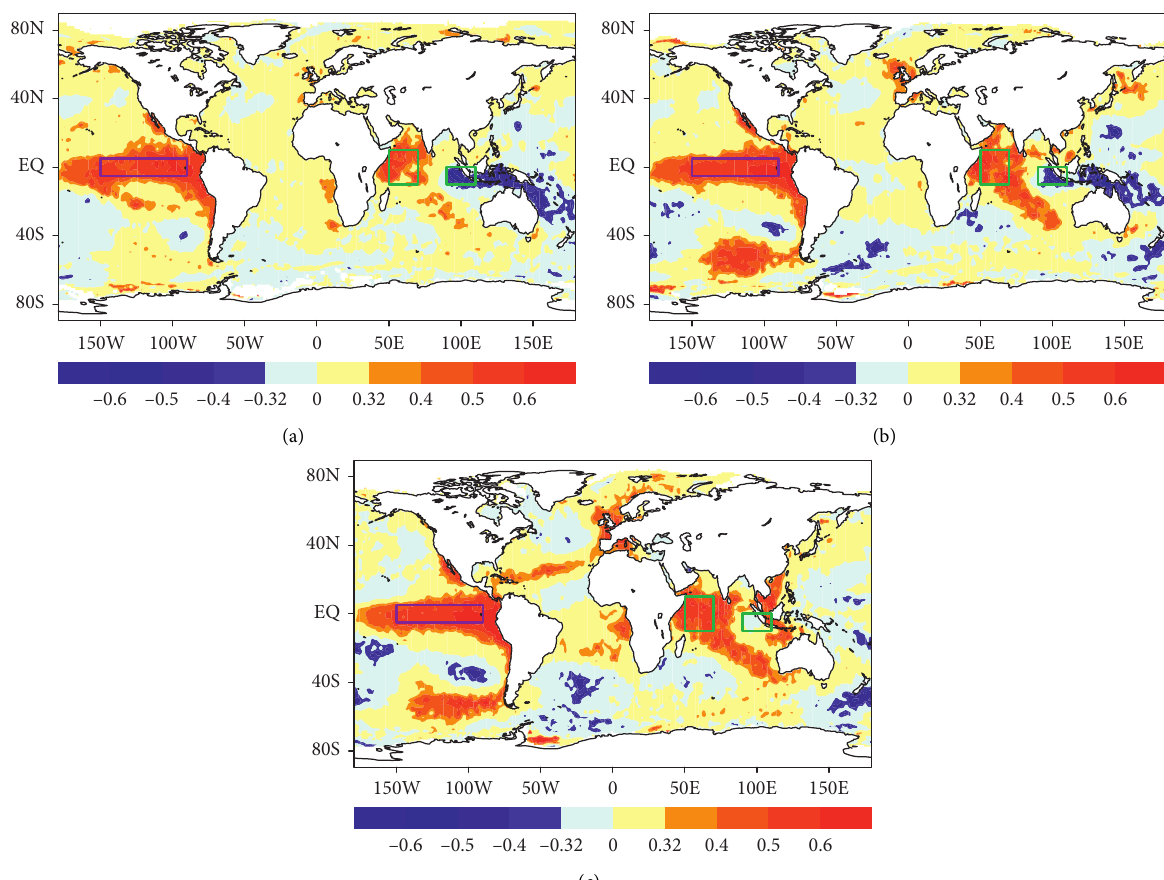
Figure 8: Correlation coefficients between the OND region rainfall and global SST in (a) October, (b) November, and (c) December. Areas with 95% confidence level are shown in dark shades. Purple box marks Nin ̃ o3.4 region and green boxes are western IO and eastern IO,